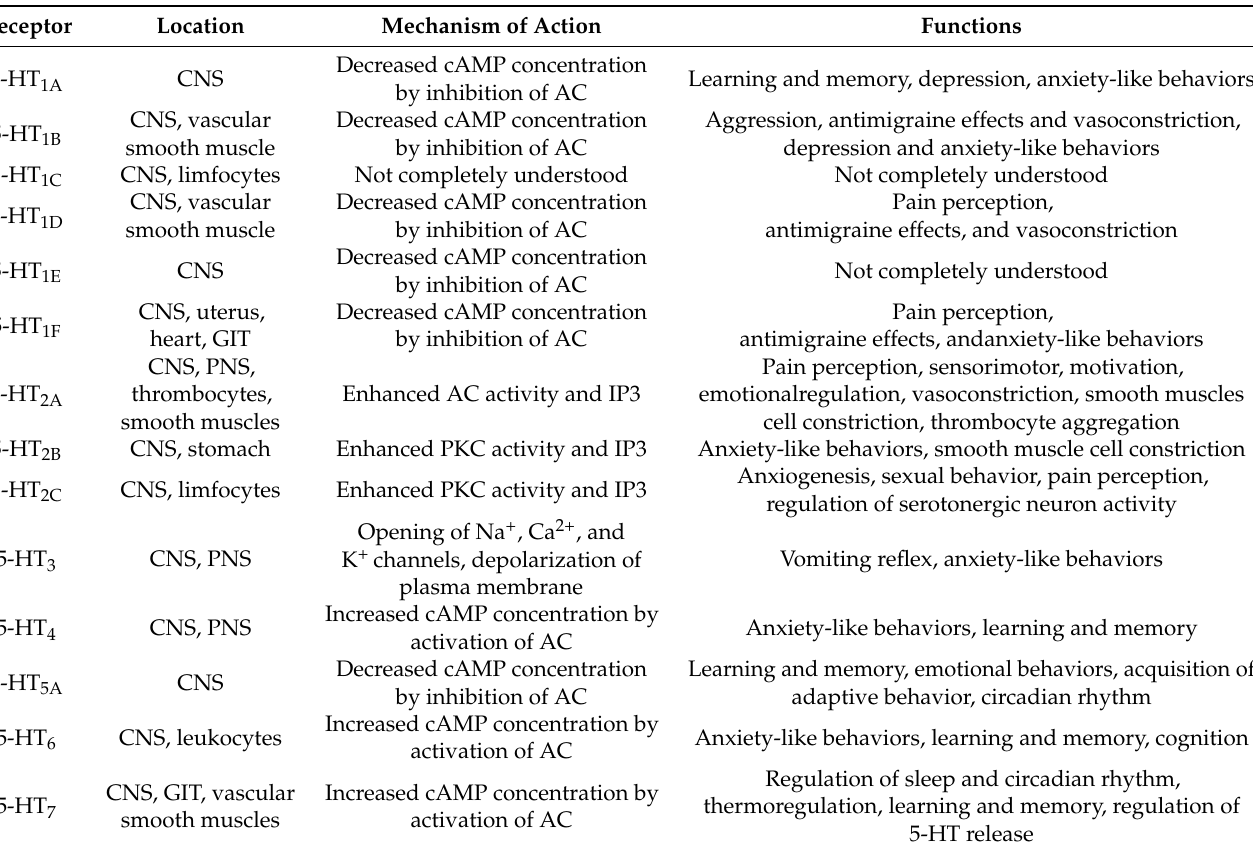
Table 2. Serotonin (5-HT) receptor subtypes. CNS, central nervous system; cAMP, cyclic adenosine monophosphate; AC, adenylate cyclase; GIT, gastrointestinal tract; IP3, inositol-1,4,5-triphosphate; PKC, protein kinase C.